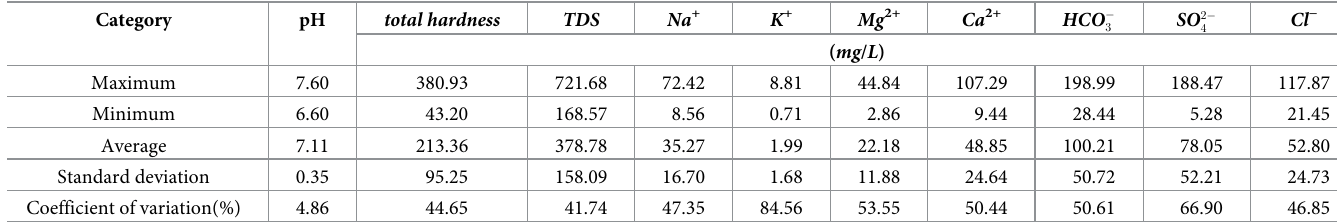
Table 3. Hydrochemical indicators in AREA I.